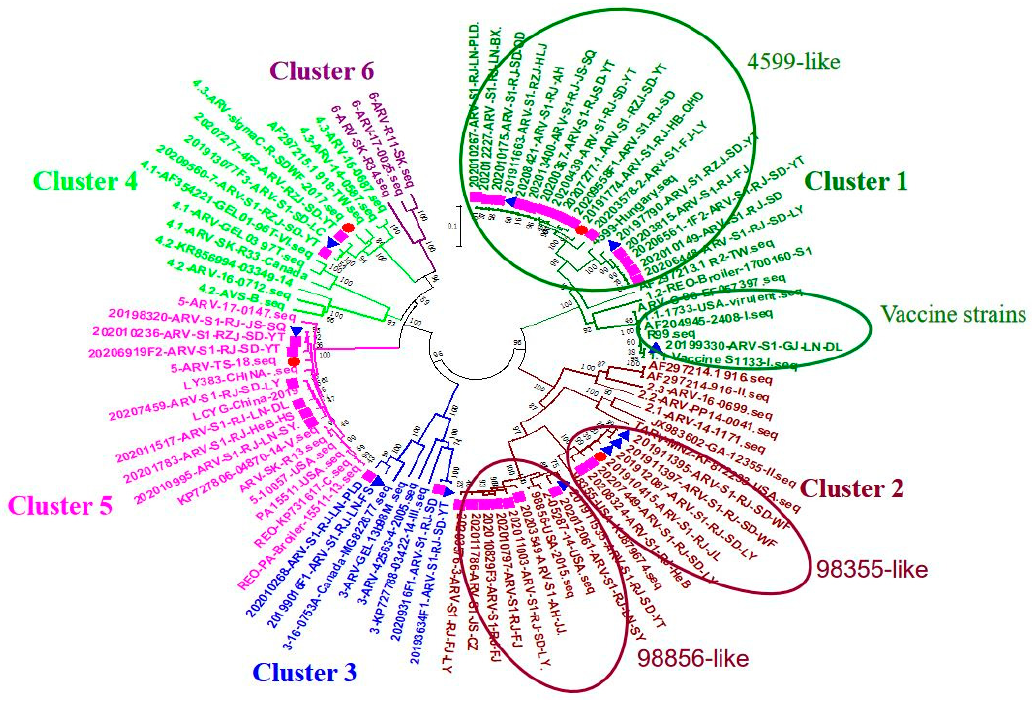
Figure 1. Phylogenetic tree of Avian reovirus virus (ARV) strains based on the σ C sequence variability. ARV strains isolated in 2019; ARV strains isolated in 2020; challenge virus.